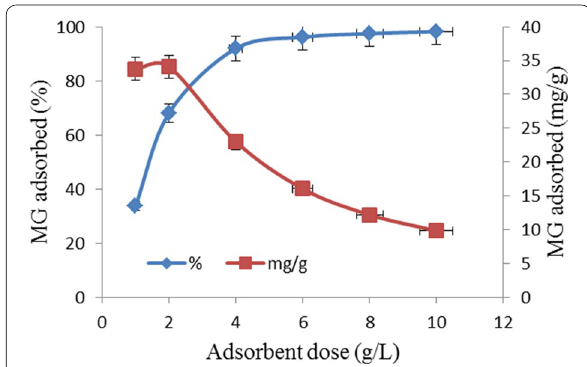
Fig. 2 Effect of TLLP dosage on removal of MG from solution